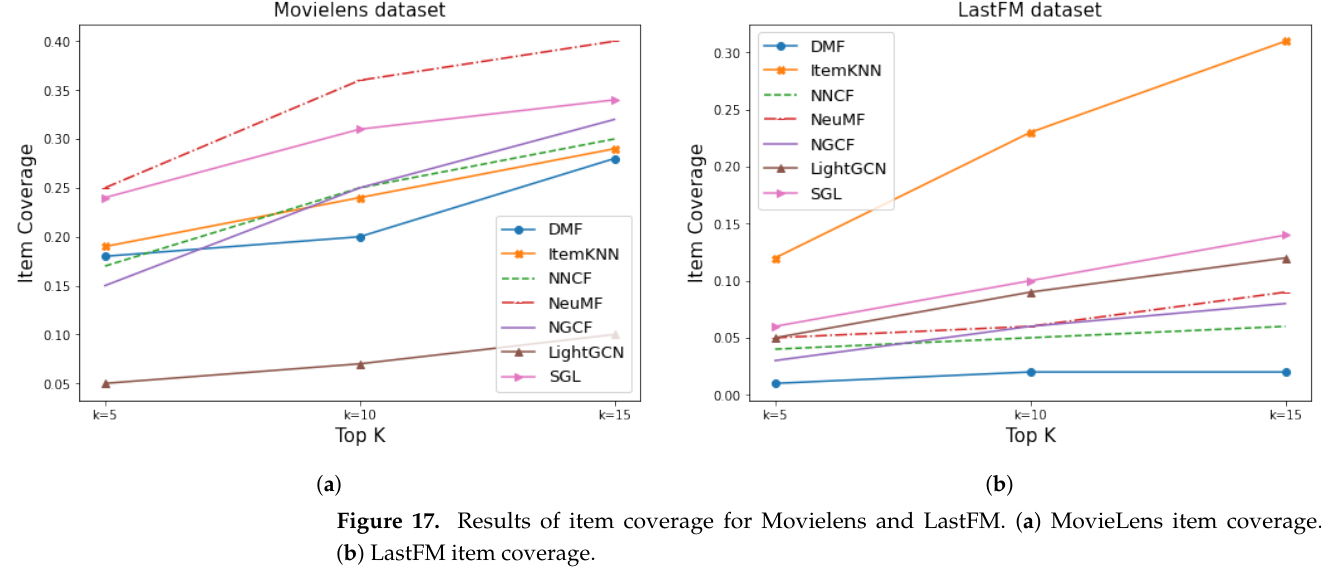
Figure 17. Results of item coverage for Movielens and LastFM. ( a ) MovieLens item coverage. ( b ) LastFM item coverage.